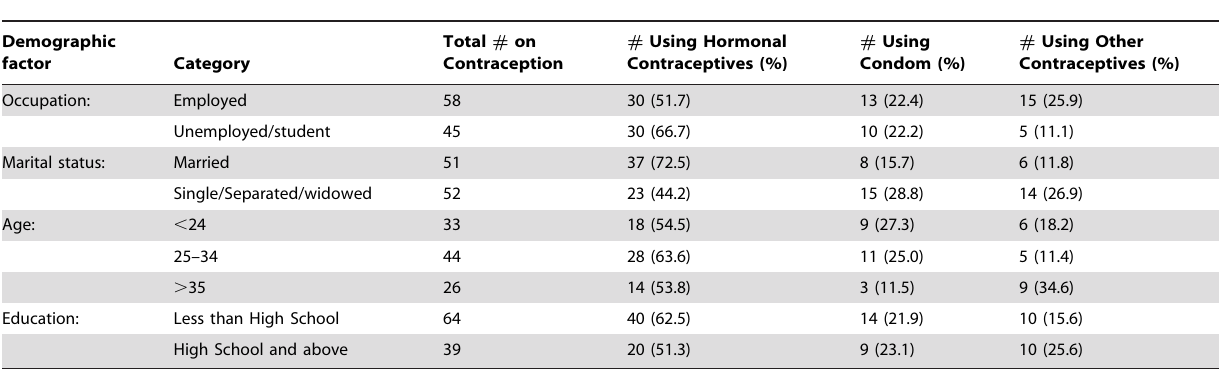
Table 3. Pattern of Contraceptive Use at Enrolment by Selected Demographic Factors (All Sites)